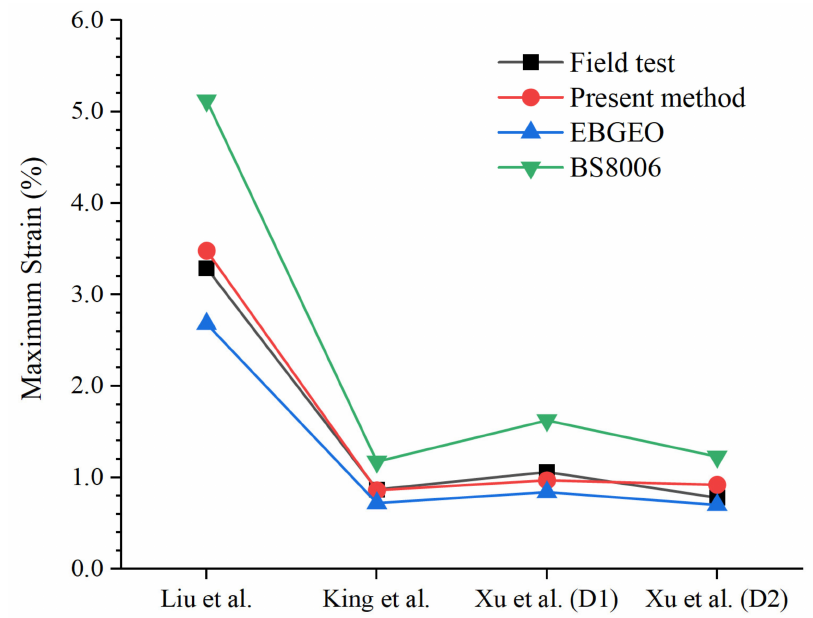
Figure 12. Comparison of results for maximum strain of